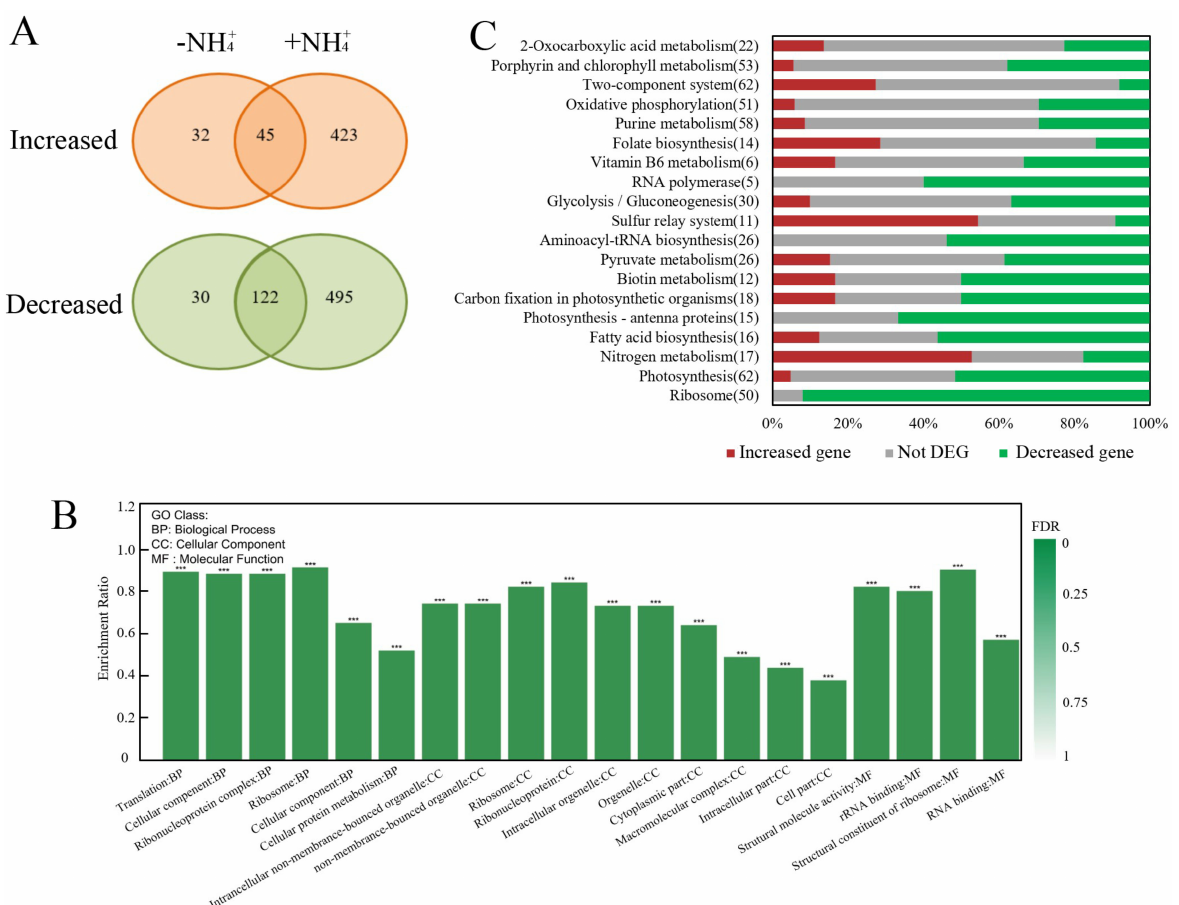
Figure 2. Transcriptional profile in ∆ slr1821 compared with the wild type (WT). ( A ) Total number of genes which were significantly increased or decreased in ∆ slr1821 relative to WT under conditions without or with NH 4+ stress for 30 min. ( B ) The top 20 enriched GO categories in biological process, cellular component and molecular function of differentially expressed genes in ∆ slr1821 compared with WT under NH 4+ stress. The enrichment p value was adjusted through FDR (false discovery rate) and FDR < 0.001 are labeled as ***. ( C ) Distribution of the significantly increased or decreased genes in ∆ slr1821 compared with WT under NH 4+ stress in the enriched KEGG